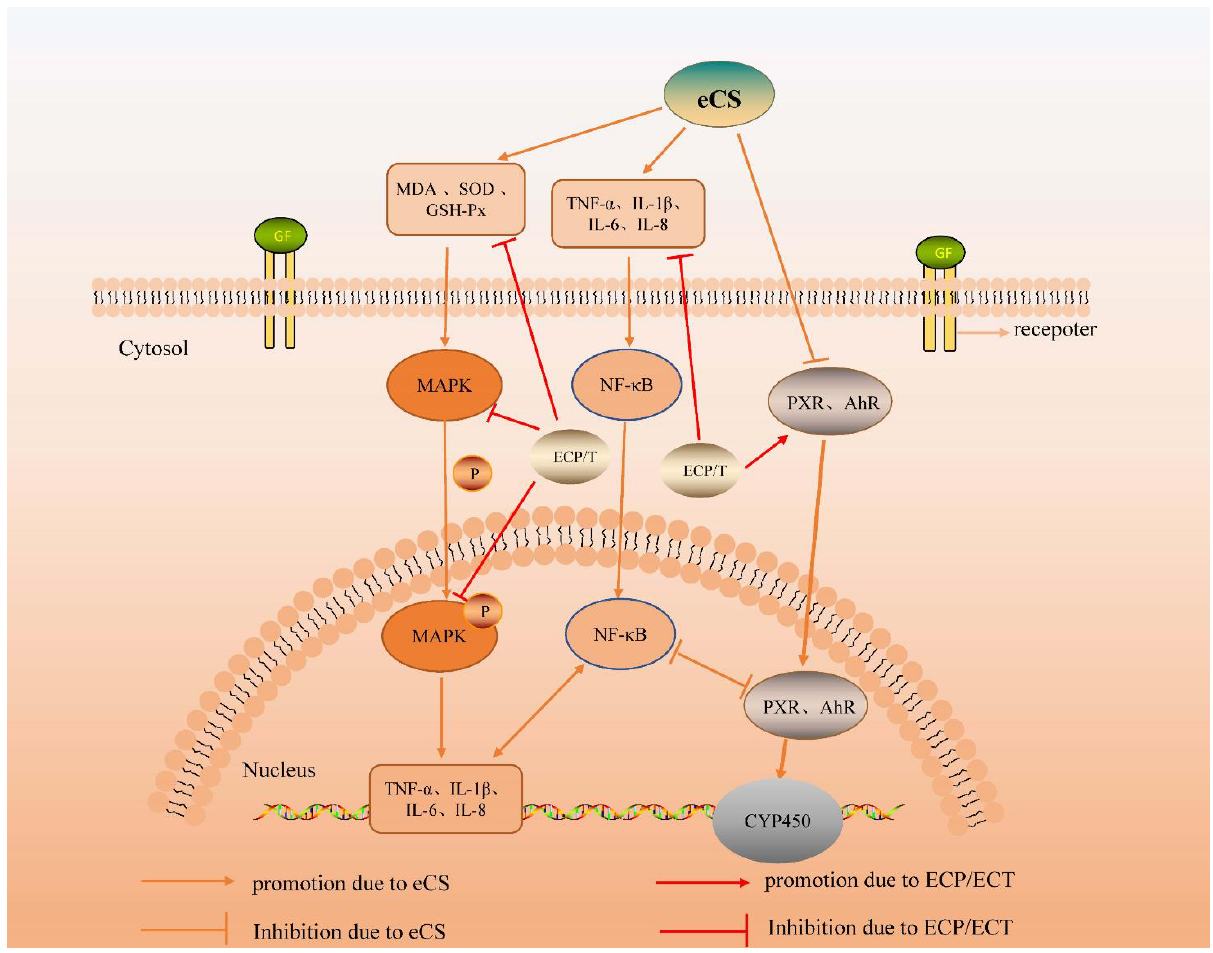
Figure 9. Effect of ECP and ECT on MAPK signaling pathways in eCS-induced lung injury and PXR/AhR signaling pathway in eCS-induced liver injury in